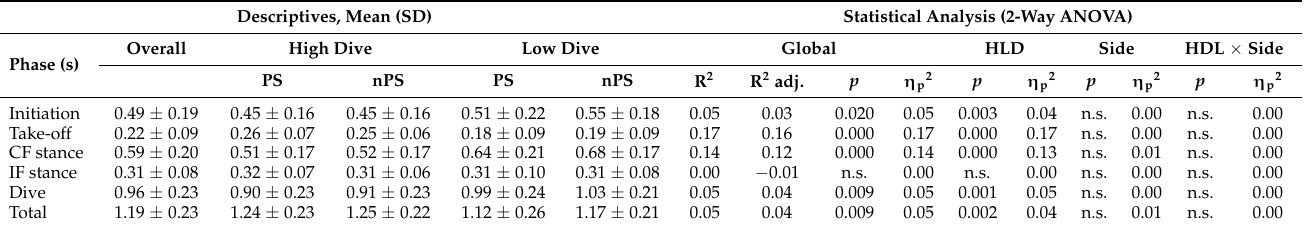
Table 2. Time performance in high and low dives according to the preferred diving side.